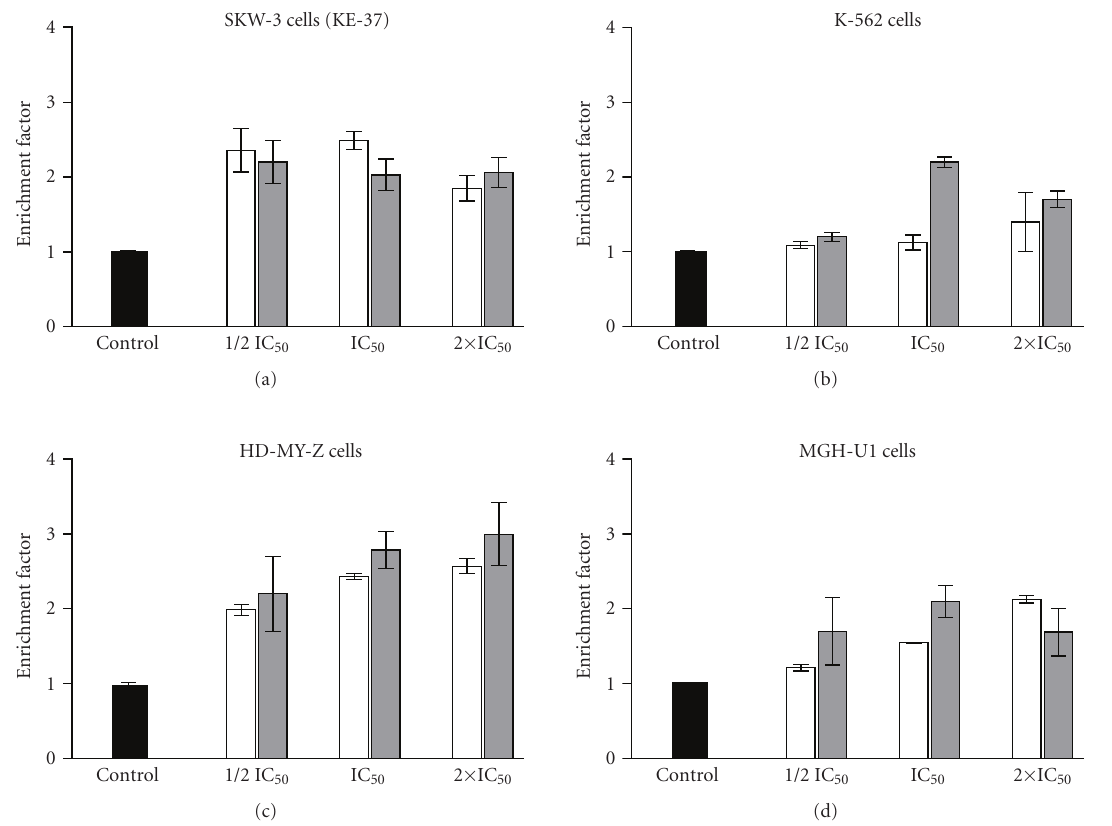
Figure 4: Internucleosomal DNA fragmentation in SKW-3, K-562, HD-MY-Z, and MGH-U1 cells after 24-hour exposure to equipotent .(H 2 O) ] (white columns) or cisplatin (gray columns). The level of DNA fragmentation expressed as the concentrations of [Au(II)Hp 2 -2H corresponding enrichment factor (ef = 1 in untreated control) was determined using “Cell Death Detection” ELISA (Roche Diagnostics).